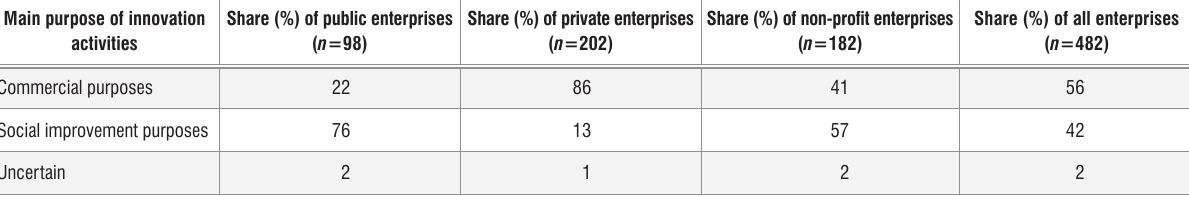
Share (%) of enterprises engaging in innovation activities for commercial or social welfare purposes by enterprise type Main purpose of innovation